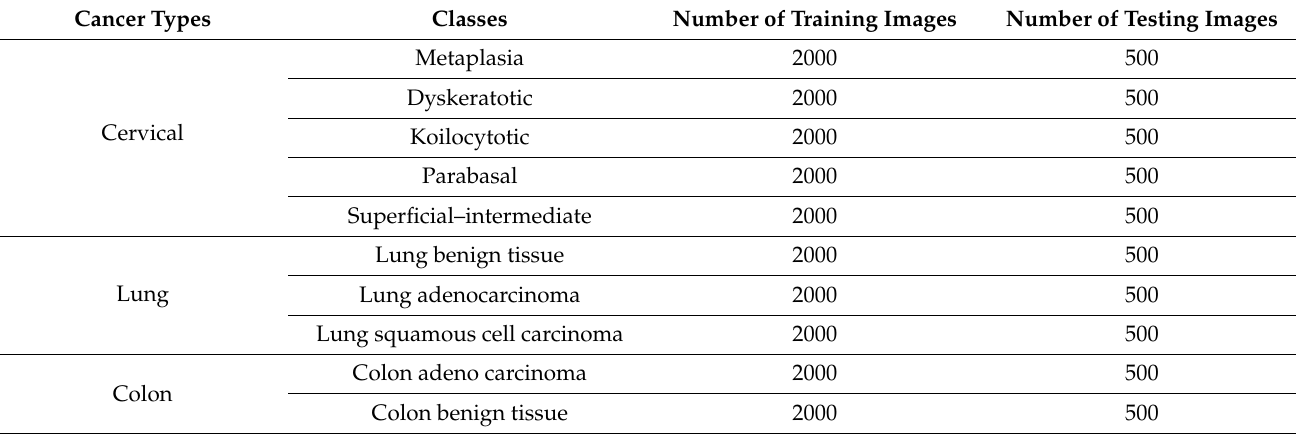
Table 2. Dataset